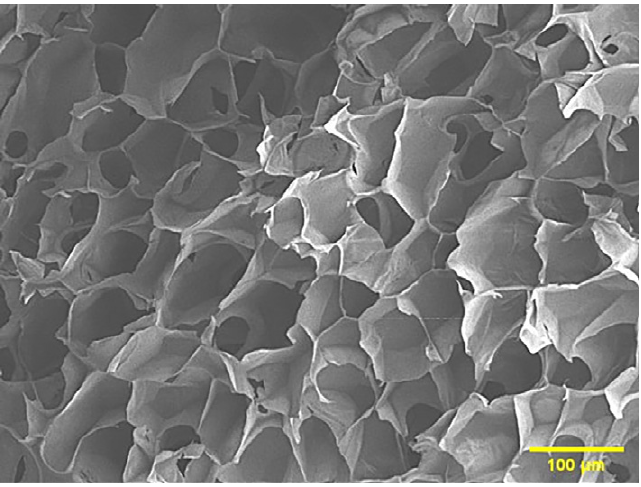
Figure 14. The scanning electron microscope view of chitosan demethylcellulose sodium stent.